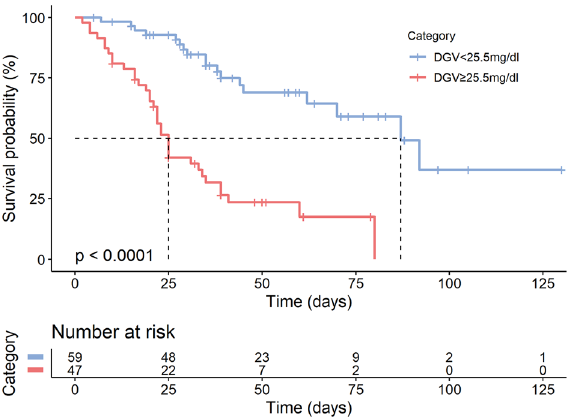
Figure 4. Kaplan–Meier Survival for ARDS Patients. Kaplan–Meier survival curves for patients with low (< 25.5 mg/dl) and high (≥ 25.5 mg/dl) daily glycaemic variability (DGV). Each cross on a curve represents a censored patient (survived to discharge), while each step in the curve represents a deceased patient. The x-axis represents the time in days to discharge. Survival curves were compared, and p -values calculated by log-rank test.